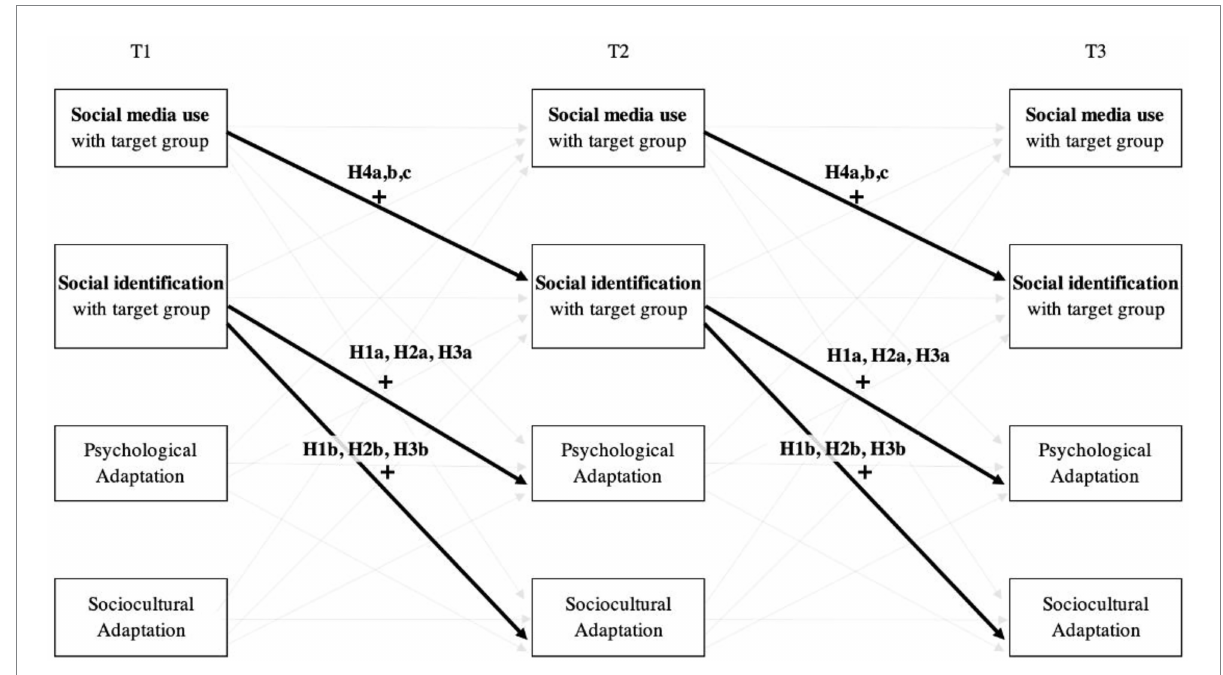
FIGURE 1 Conceptual model of the effects of social media use and social identification variables on the psychological and sociocultural adaptation of international students during their